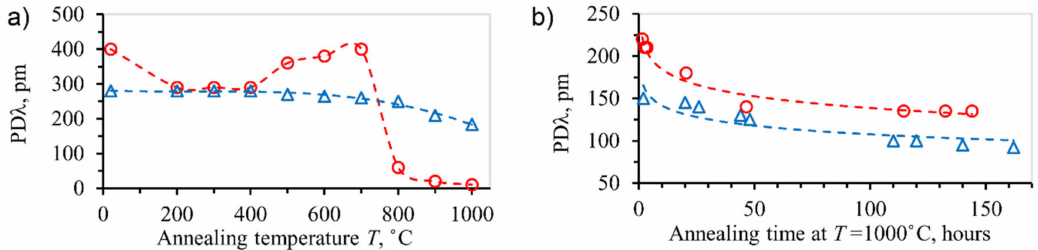
Figure 10. ( a ) Birefringence (PD λ ) of π -shifted Type II FBG in SMF-28 (blue triangles) and polarization-maintaining Fibercore HB1500 PM fiber (red circles). ( b ) wavelength drift of π -shifted Type II FBG in SMF-28 for different levels of the initial birefringence (blue: ~2.6 × 10 − 4 ; red: ~4.2 × 10 − 4 ), reproduced from [56].